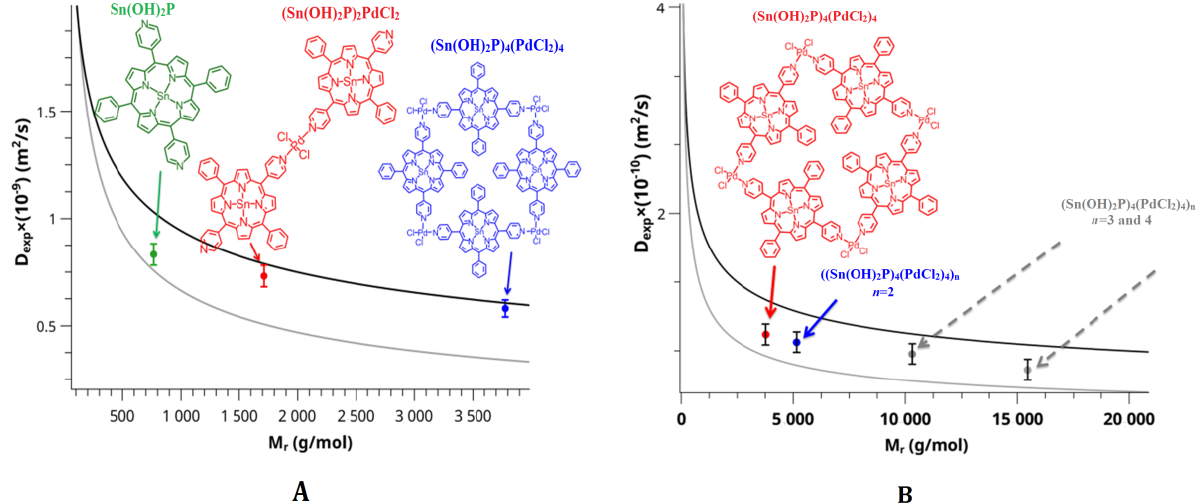
Figure 3. Graphical analysis of self − diffusion coefficients versus molecular weight from DOSY NMR spectroscopy. ( A )The green dot is the monomeric structure of Sn(OH) 2 P 1 , the red dot is the structure of complex 5 , the blue dot is the structure of complex 2. ( B ) The red dot is the monomeric structure of the (Sn(OH) 2 P) 4 (PdCl 2 ) 4 complex 2 , the blue dot is the dimeric structure of the complex 2 , two additional gray dots correspond to the trimeric and tetrameric structures of the complex 2 , the presence of which is also likely.